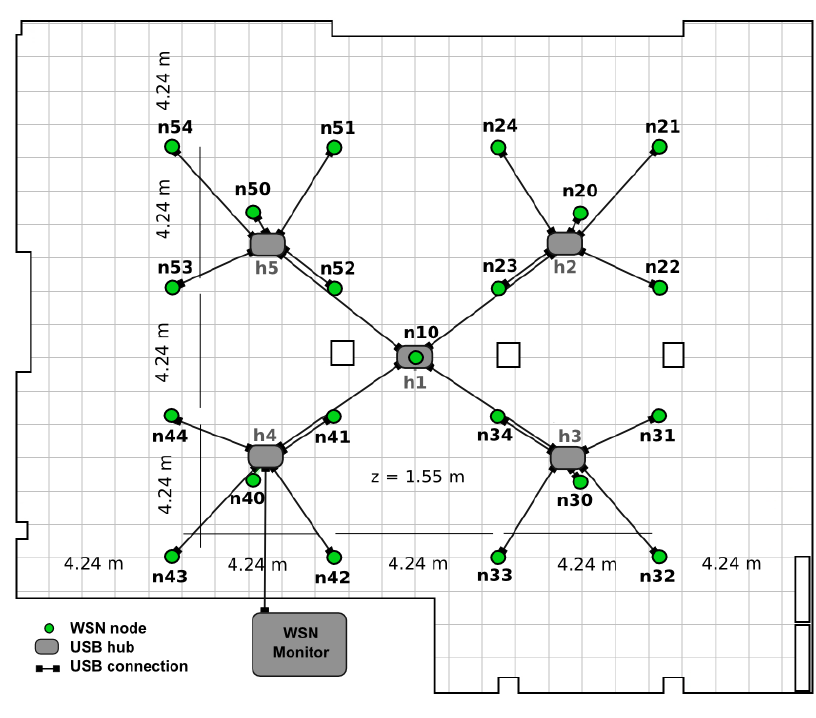
Figure 3. Deployment of the static WSN in the testbed room.